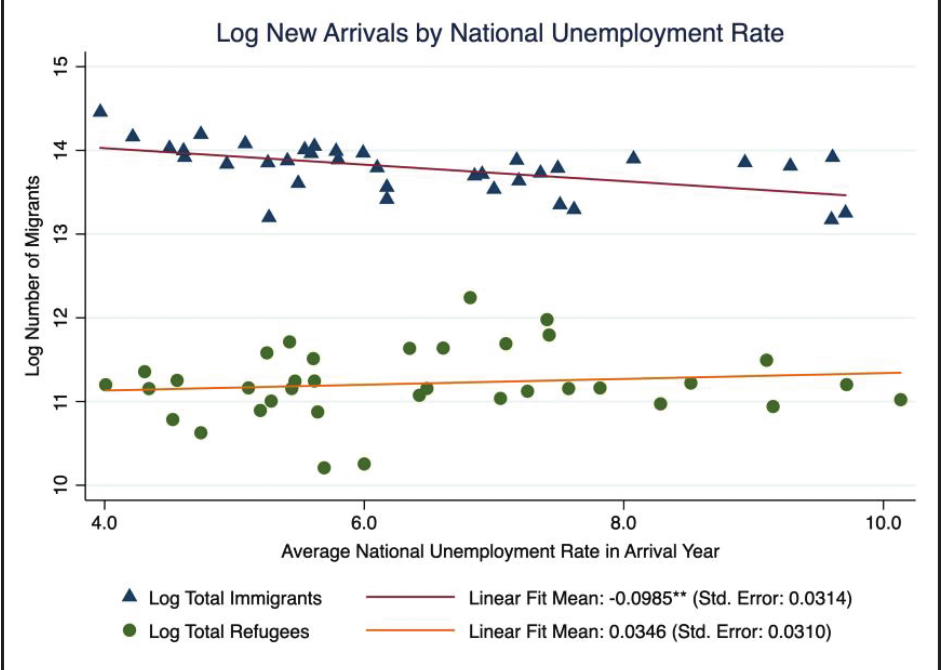
Figure 2 Log new arrivals by National Unemployment Rate